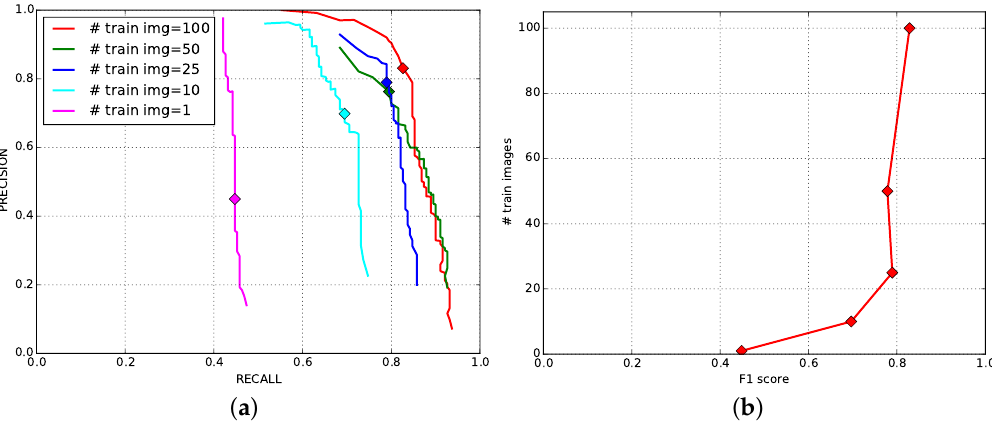
Figure 11. ( a ) Precision-recall curves with the varying number of training images as denoted by different colours. The marks indicate the points where precision and recall are identical; ( b ) The F1 scores versus the number of images being used for